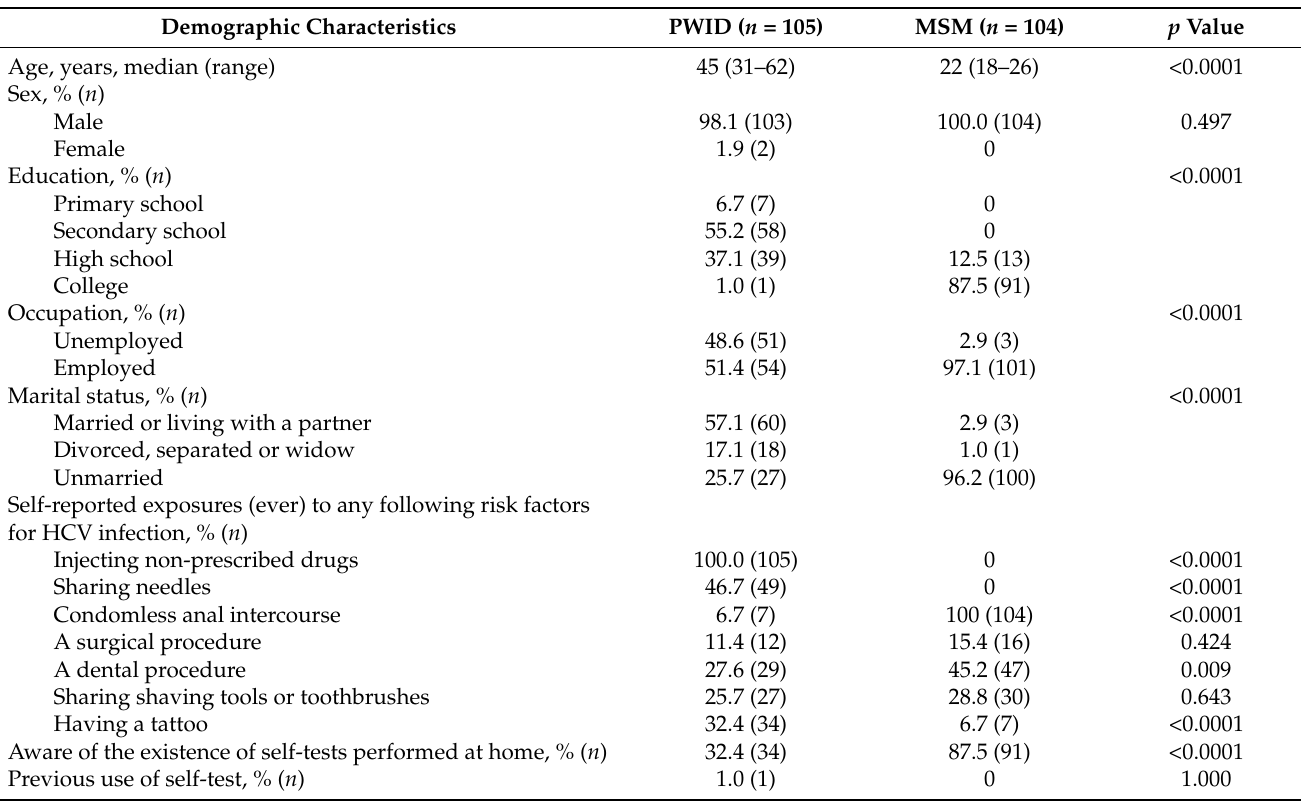
Table 1. Baseline demographic characteristics of study participants.